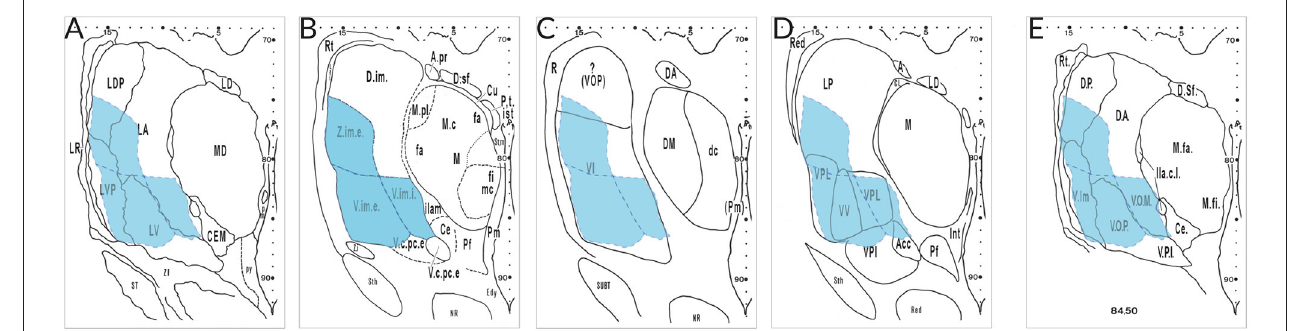
FIGURE 3 | Delineations of the same cell- and fiber-stained sections at mid-thalamic level presented by different specialists. The diagrams were taken from the atlas edited by Dewulf after the Louvain Conference 1963 (publ. 1971) from the following authors: (A) , Feremutsch and Simma; (B) , Hopf; (C) , Macchi; (D) , Krieg; (E) , Feremutsch and Simma (“standardized nomenclature”). Since all five delineations refer to the same section the V.im region demarcated by Hopf (blue color) was superimposed over the remaining diagrams. The V.im region defined by Hopf (V.im.e, V.im.i, and Z.im.e) is overlapping parts of LDP, LA, LV, and LVP in the diagram of Feremutsch and Simma; it corresponds to the major part of VI but also reaches VOP (Macchi); it is designated as VPL and VV but encroaches also LP, VPI, and Acc (Krieg) and is designated in the “standarized nomenclature” as Vim, VOP and VOM but also includes parts of DP and DA, respectively. Acc, not specified (N. arcuatus); DA, not specified (N. dorsalis anterior); DP, not specified (N. dorsalis posterior); LA, N. lateralis thalami, pars principalis; LDP, N. lateralis thalami, pars dorsalis posterior; LP, N. lateralis posterior; LV, N. lateralis thalami, pars ventralis; LVP, N. lateralis thalami, pars ventralis posterior, V.im.e/i; Ncl. intermedius, pars externa/ interna; VI, Ncl. ventralis intermedius; VOM, not specified (Ncl. ventrolateralis, pars medialis); VOP, Ncl. ventrolateralis, pars posterior; VPI, Ncl. ventralis posterior inferior; VPL, Ncl. ventralis posterior lateralis; VV, N. ventralis ventralis; Z.im,e, Ncl. zentrolateralis intermedius, pars externa.